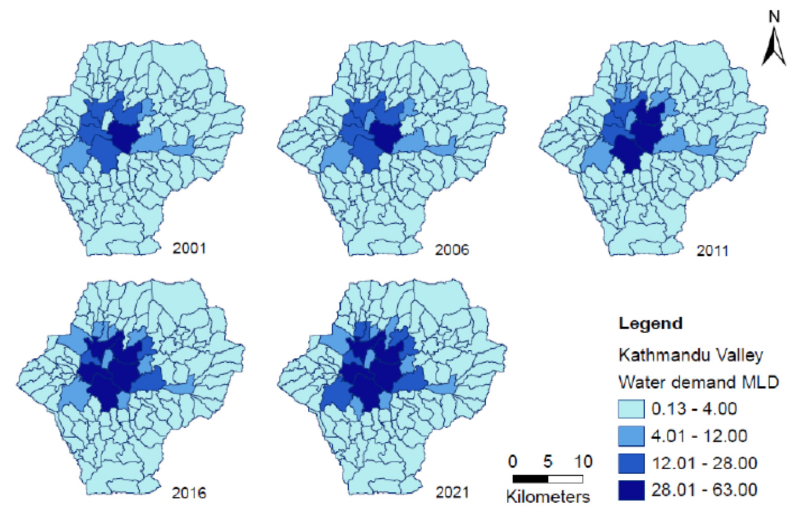
Assuming 135 lpcd